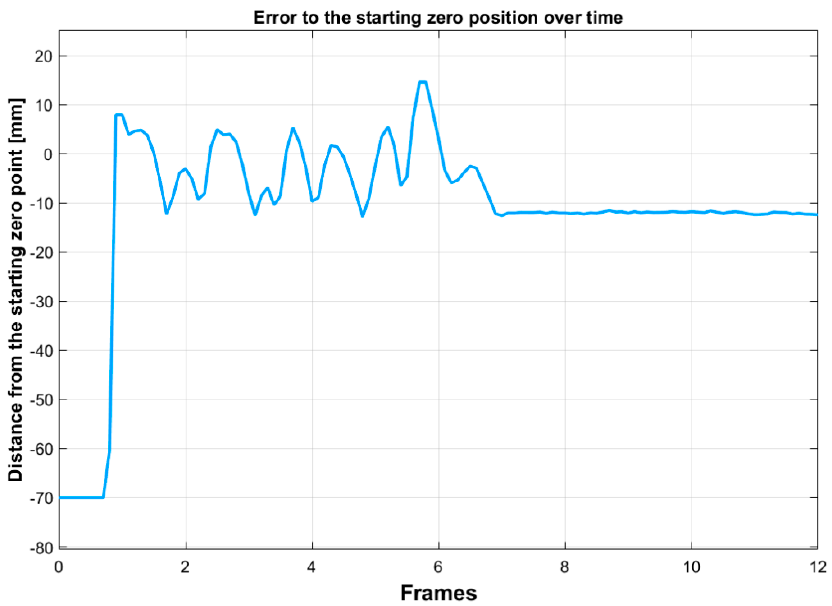
Figure 14. Error to the starting zero point with a 0.09 gain value.